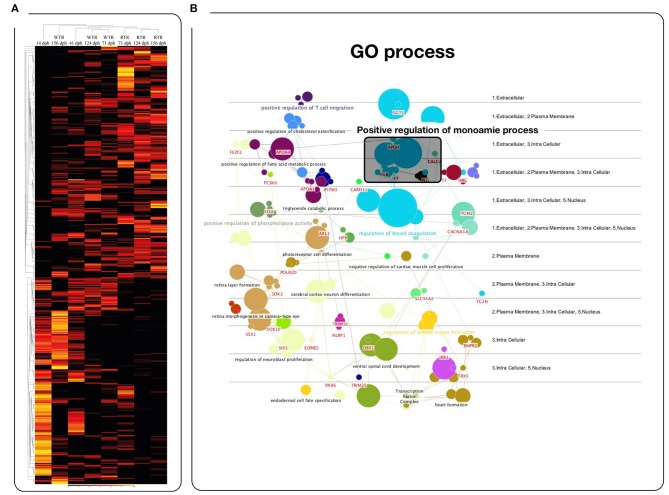
Effects of the temperature on the gene expression levels. (A) Heatmaps of log2-transformed gene expression levels for rank-associated genes of each thermal range during the development. (B) Gene ontology enrichment analysis of 415 differentially expressed transcripts (GO DAVID and ClueGo Cytoscape Plugin) in Salmo salar brain during development (156 days post-hatching). Experimental groups are restricted thermal range (RTR, ΔT 1.4°C) and wide thermal range (WTR, ΔT 6.8°C). Transcript abundance is represented as color scales show relative transcript expression in RPKM values.